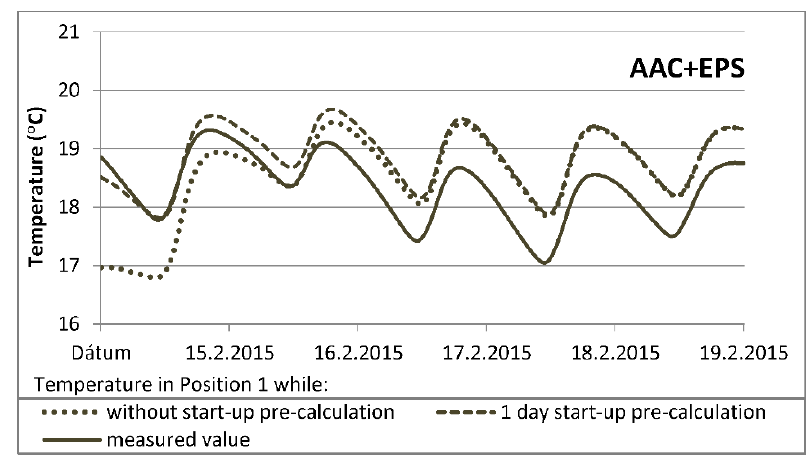
Figure 15. Plotted calculated and measured temperature courses in the outdoor test cell wall S1 in Position 1 during the chosen time period — with and without pre-calculation considerations.